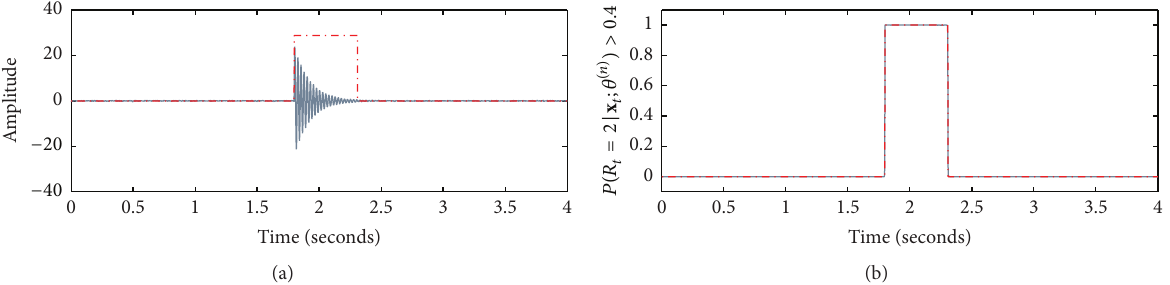
Figure 2: The application of the proposed method to the simulated signal from Section 3. (a) Detection of the seismic signal in the recorded dataset. (b) Sequence of the smoothed conditional probabilities of observing the second regime 𝑃(𝑅 𝑡 = 2 | x 𝑡 ;𝜃 (𝑛) ) (red line) including the nonsmoothed vector of 𝑃(𝑅 𝑡 = 2 | x 𝑡 ; 𝜃 (𝑛) ) marked as grey